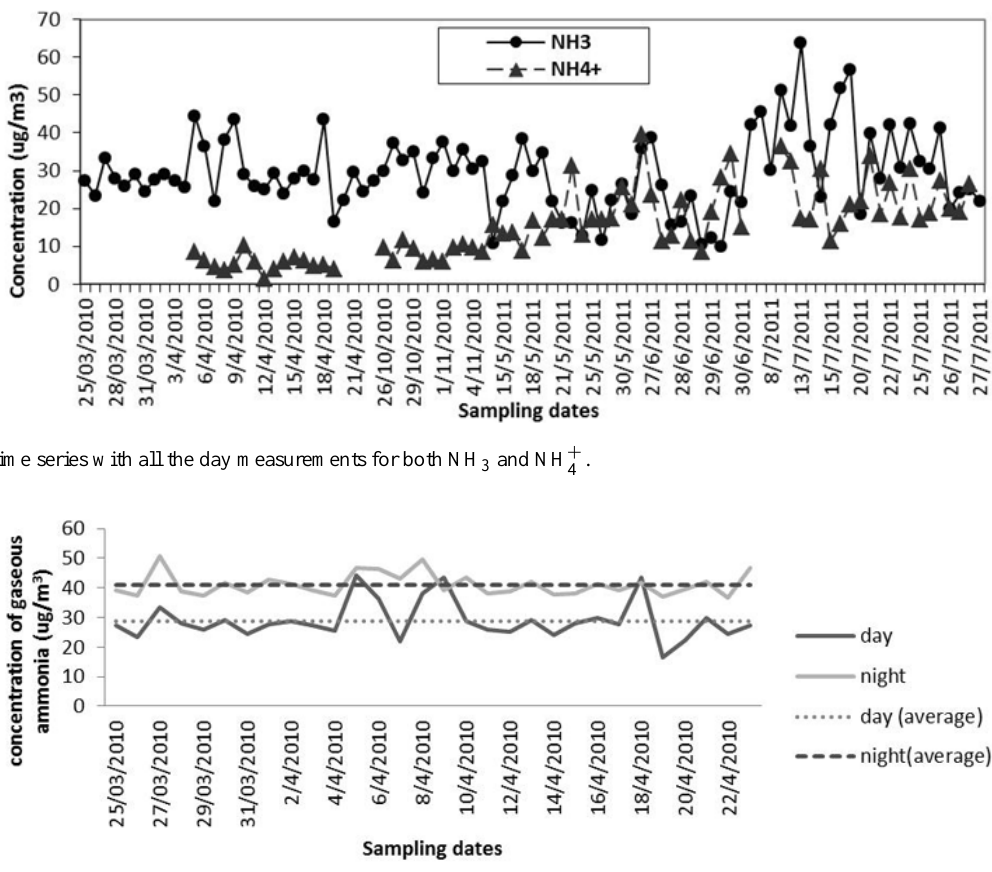
Fig. 5b. Average diurnal variation of NH 3